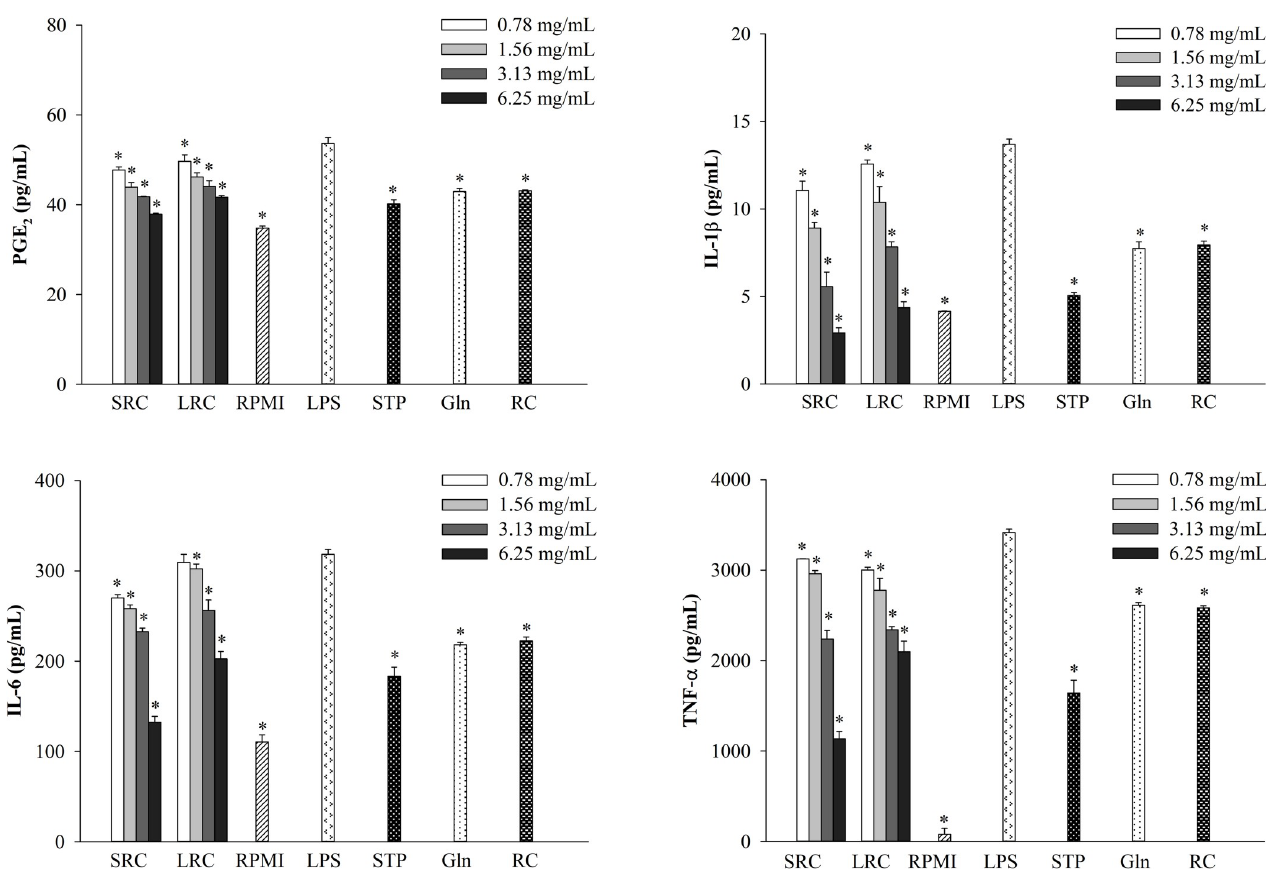
Fig 3. Effect of SRC and LRC on the production of PGE 2 , IL-1 β , IL-6, and TNF- α in LPS-stimulated RAW264.7 cells. The results are presented as the mean ± SD ( n = 3). Significant differences are p < 0.05 compared with LPS. SRC = strawberry rice cake, LRC = L-glutamine rice cake, STP = strawberry powder, L-glutamine = Gln, and RC = rice